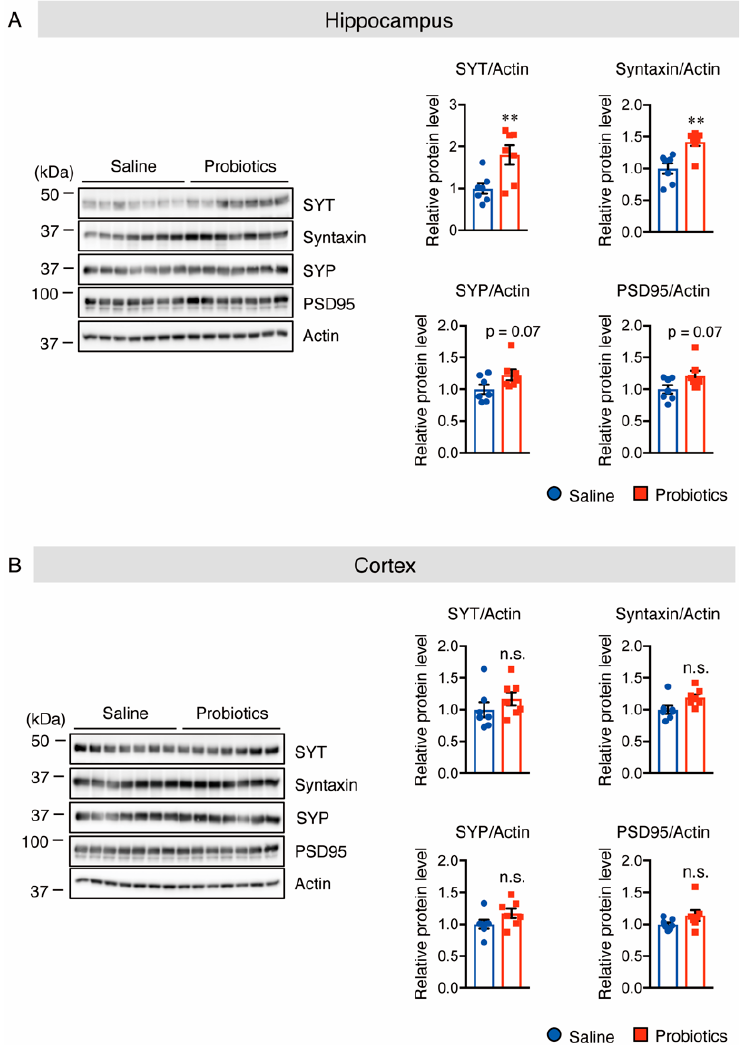
Figure 6. Oral supplementation of B. breve MCC1274 upregulates synaptic protein levels in the hippocampus of WT mice. Western blot analysis of SYT, syntaxin, SYP, PSD95, and actin in the hippocampus ( A ) and cortex ( B ). The protein levels were quantified by densitometry, normalized to the actin level, and expressed as a relative protein level. Data are represented as mean ± SD; n = 7 per group; n.s. no significant difference; ** p < 0.01 compared with the saline group, as determined by Student’s t -test.